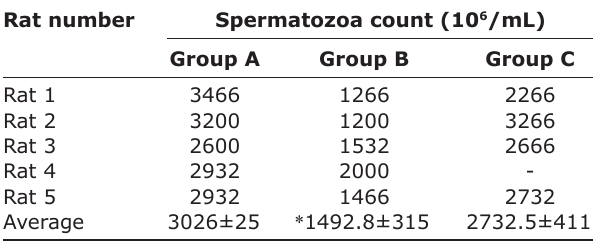
Table-2: The number of spermatozoa from the caudal epididymis.